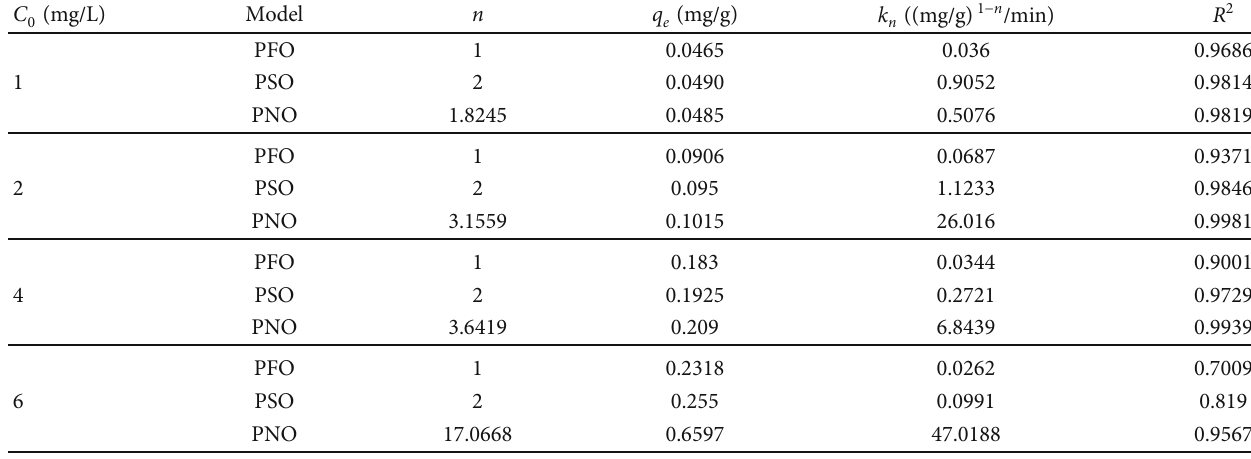
Table 6: Kinetic parameters and coe ffi cients of determination for the PFO, PSO, and PNO models for the adsorption of Cd(II) by reed leaves for initial Cd(II) concentrations of 1, 2, 4, and